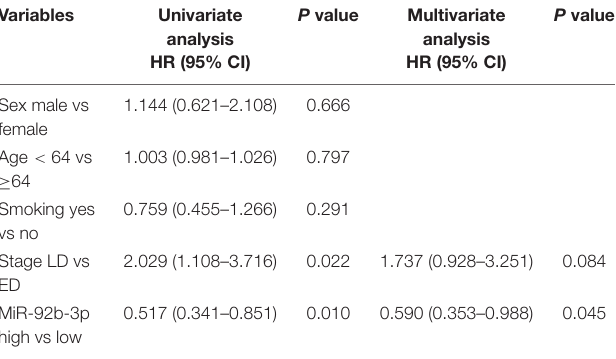
TABLE 1 | Univariate and multivariate prognostic analyses of SCLC.